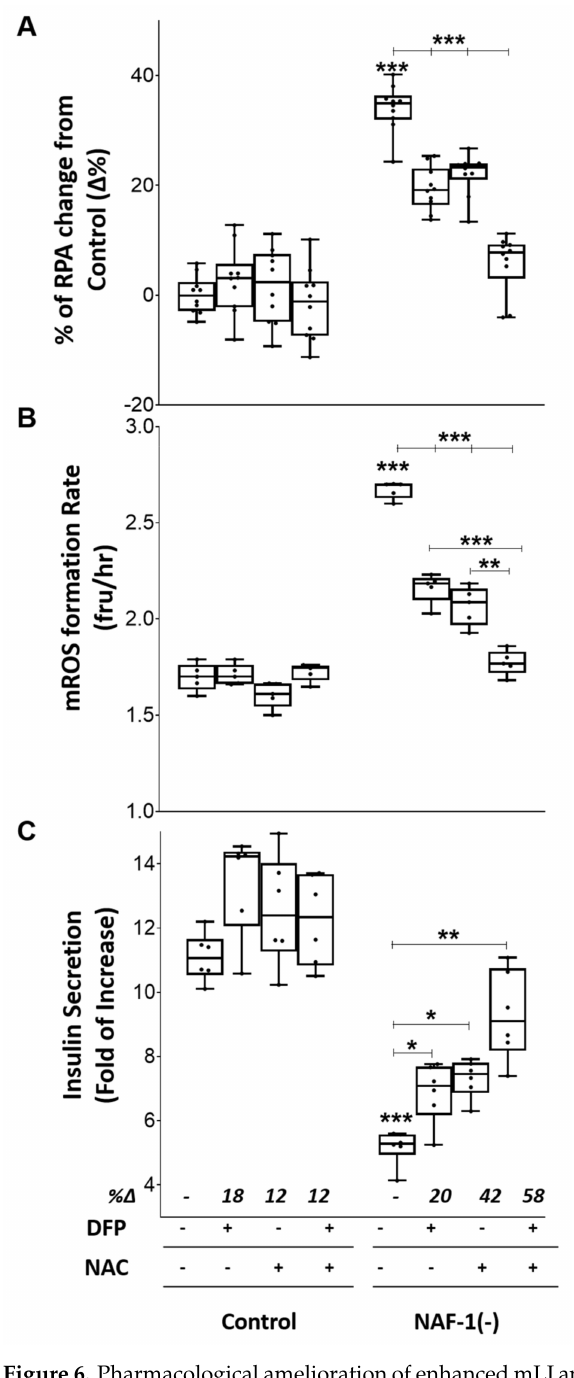
Figure 6. Pharmacological amelioration of enhanced mLI and mROS, and decrease insulin production in NAF-1( − ) INS-1E cells with a combined treatment of DFP and NAC. ( A ) Mitochondrial labile iron levels in control and NAF-1( − ) cells in the presence or absence of DFP (50 µ M) and/or NAC (100 µ M). ( B ) Same as in ( A ), but for mROS levels. ( C ) Fold change in glucose-stimulated insulin secretion of control and NAF-1( − ) cells in the presence or absence of DFP and/or NAC. The results are shown as box-and-whisker plots and include all data points measured from three different experiments. * p < 0.05, ** p < 0.01, *** p < 0.001, compared to control; Student’s t -test, N = 450 for ( A ), N = 150 for ( B ), and N = 3 for ( C ). Abbreviations: DFP, deferiprone; NAC, N - acetyl